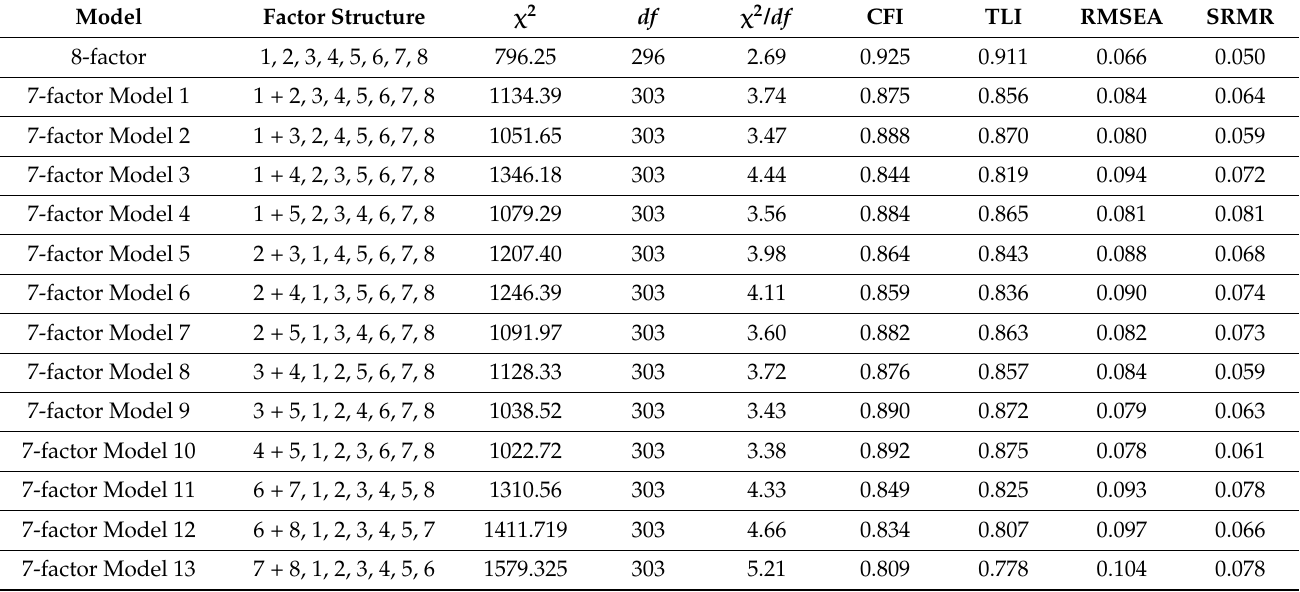
Table 4. Confirmatory factor analysis model